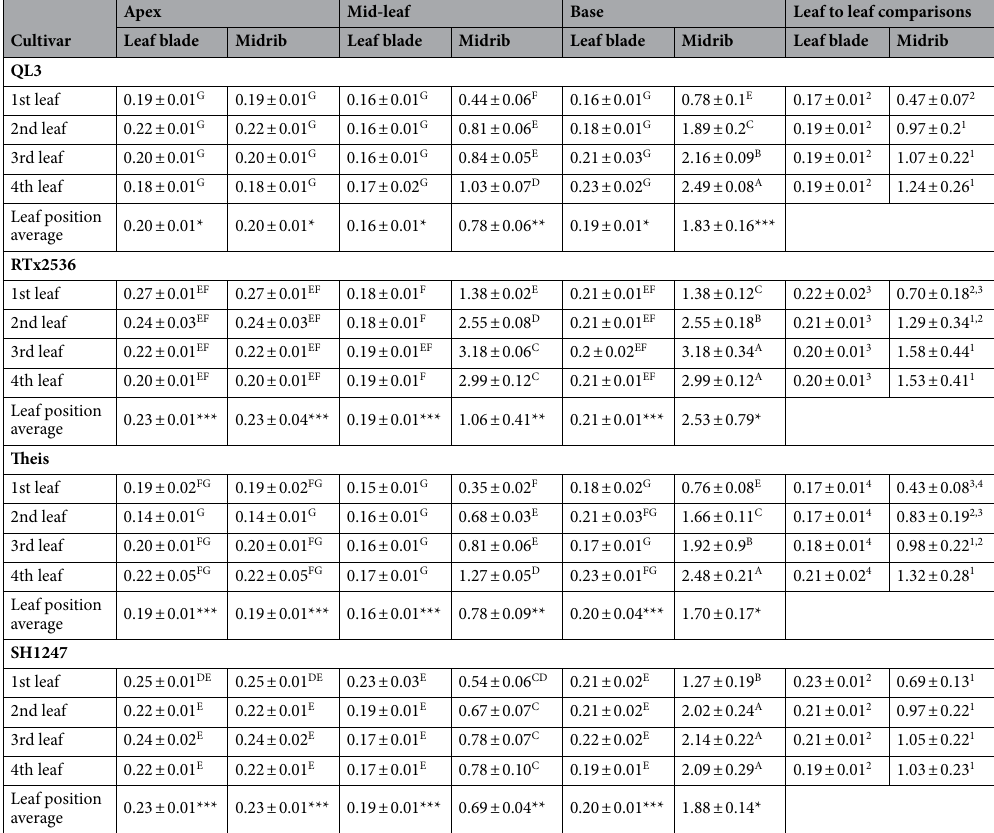
Table 2. Leaf thickness comparisons in three sorghum and one Johnsongrass cultivars. A student’s t-test for all possible group comparisons within each cultivar for leaf thickness at three points (near apex, near base, and half-way between apex and base) as were the leaf to leaf comparisons and leaf position comparisons. Upper to lower leaves were labeled as 1st leaf to 4th leaf. Leaf blade and midrib tissues were measured separately. Unit = mm. Statistically different groups are labeled with letters for specific locations, number(s) for different leaves, and number of asterisk marks for leaf blade/midrib at apex/middle